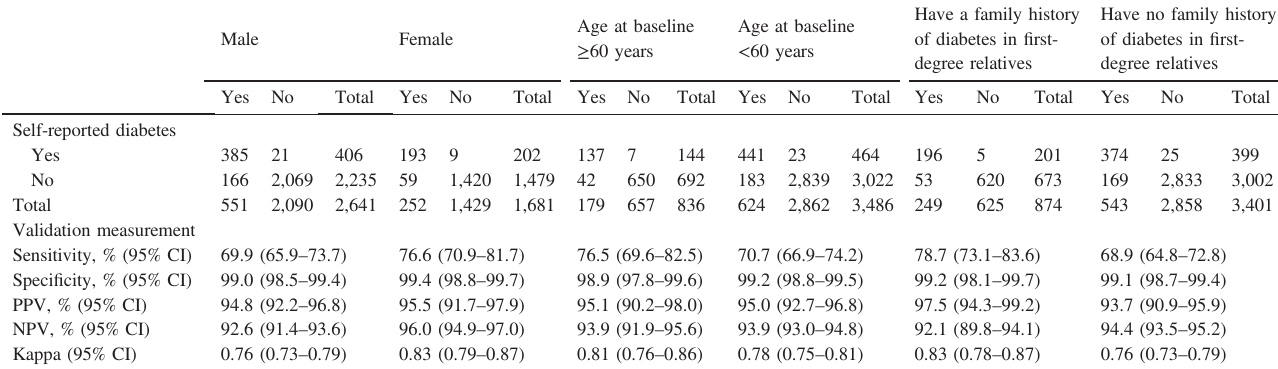
Table 3. Subgroup analysis by gender, age, and family history in validation study of self-reported type 2 diabetes in Shanghai ( n =